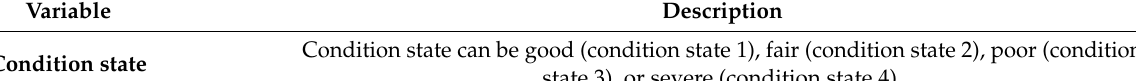
Table 1. Descriptions of prospective deterioration factors and output condition state